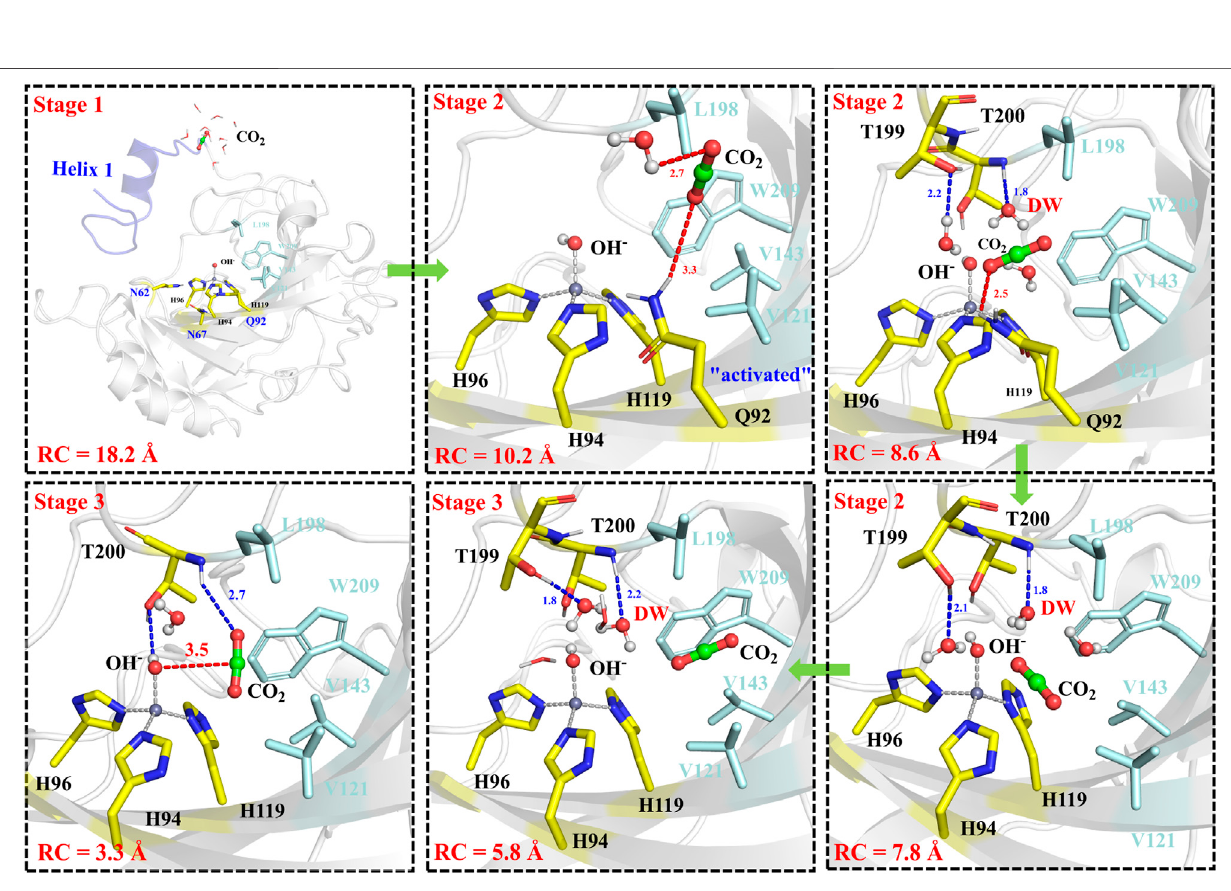
Figure 9B , the whole CO 2 transportation process can be subdivided into three stages: 1) The initial stage (RC1 ≥ 10.4 Å). CO 2 , surrounded by water molecules through the hydrogen bond interaction, is outside of the protein; 2) The second stage (6.6 Å ≤ RC1 < 10.4 Å). CO 2 is getting into the protein gradually, while it is still out of the hydrophobic pocket,